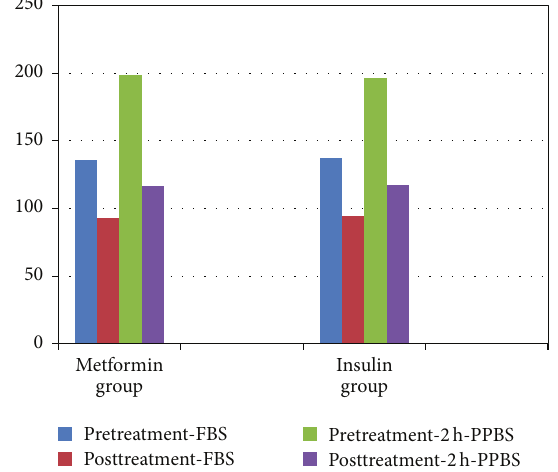
Figure 2: The figure shows pattern of blood sugar in both groups before and after treatment (fasting blood sugar (FBS) and 2 h postprandial blood sugar (2h